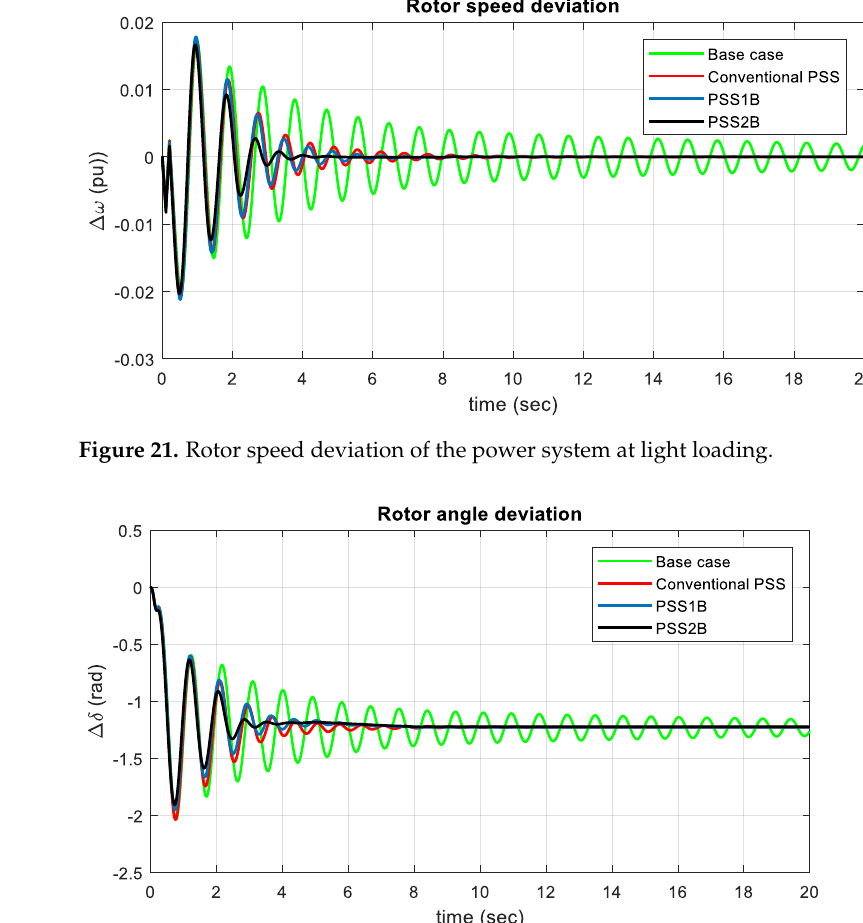
Table 14. Maximum overshoot and settling time of rotor speed deviation at heavy loading.